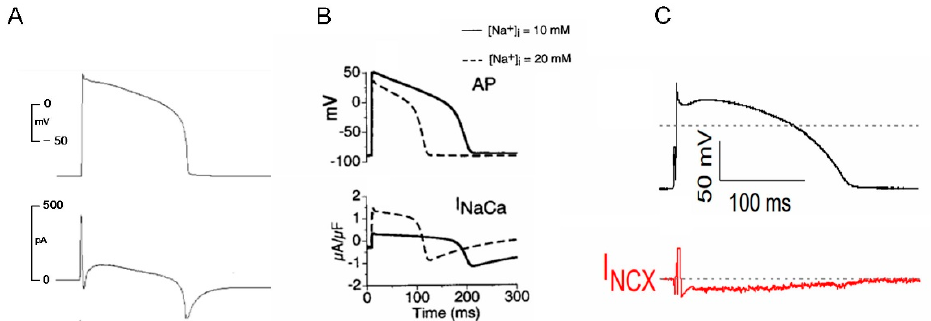
Figure 3. Estimation of NCX current during an action potential. ( A ): Noble et al. (reprinted with permission from Ref. [29]. 2022, Elsevier Science & Technology Journals), the lower panel indicates mainly outward NCX during an action potential. ( B ): Faber and Rudy action potential model demonstrates that NCX current depends on [Na + ] i (reprinted with permission from Ref. [30]. 2022, Elsevier). ( C ): Horvath et al. defined NCX current during an action potential by using the “onion- peeling” technique in dog ventricular myocytes. (reprinted with permission from Ref. [35]. 2022, Elsevier).